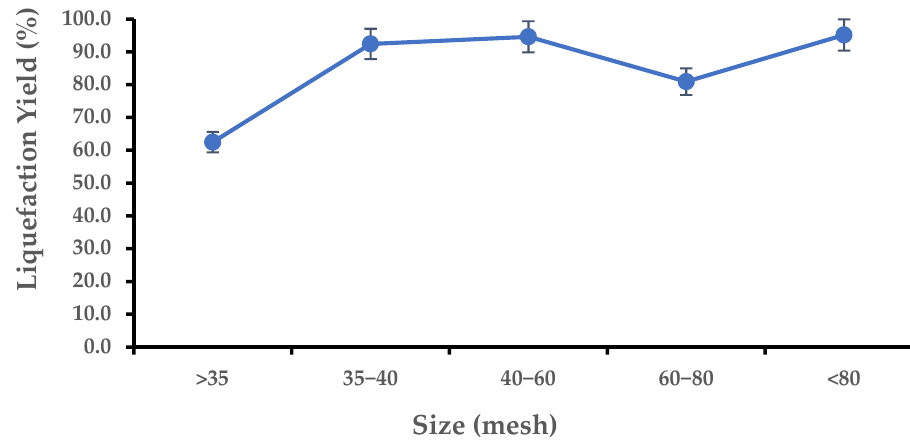
Figure 1. Liquefaction yield for different particle size for the Cytisus scoparius branches (CsB) (constant parameters: 180 °C, time 60 min and ratio CsB:solvent of 1:10).